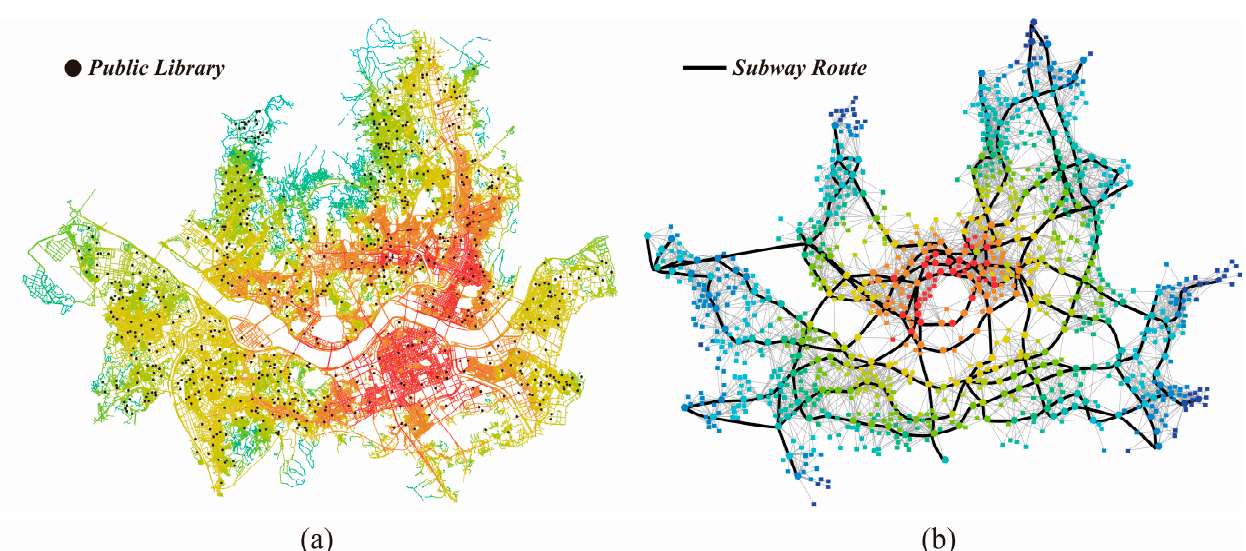
Figure 8. A 3D scatter plot created by the location integration of public libraries, integration accord- ing to control factors, and DUA. 3.2. Correlation Analysis of Factors Prior to validating the correlation of our data, it is necessary to verify the normality and independence of these relative values. Therefore, the normal data distribution was firstly examined using a P-P plot. According to Figure 9, the location accessibility of public libraries, accessibility con- sidering the control factors, and DUA-converted relative values all fell within a range close to the diagonal of the normal P-P plot. The residuals were distributed above and below the Y = 0 baseline in a ± 0.06 range. Therefore, our data followed a normal distribu- tion. Based on this, the Friedman test was conducted on the derived relative values to